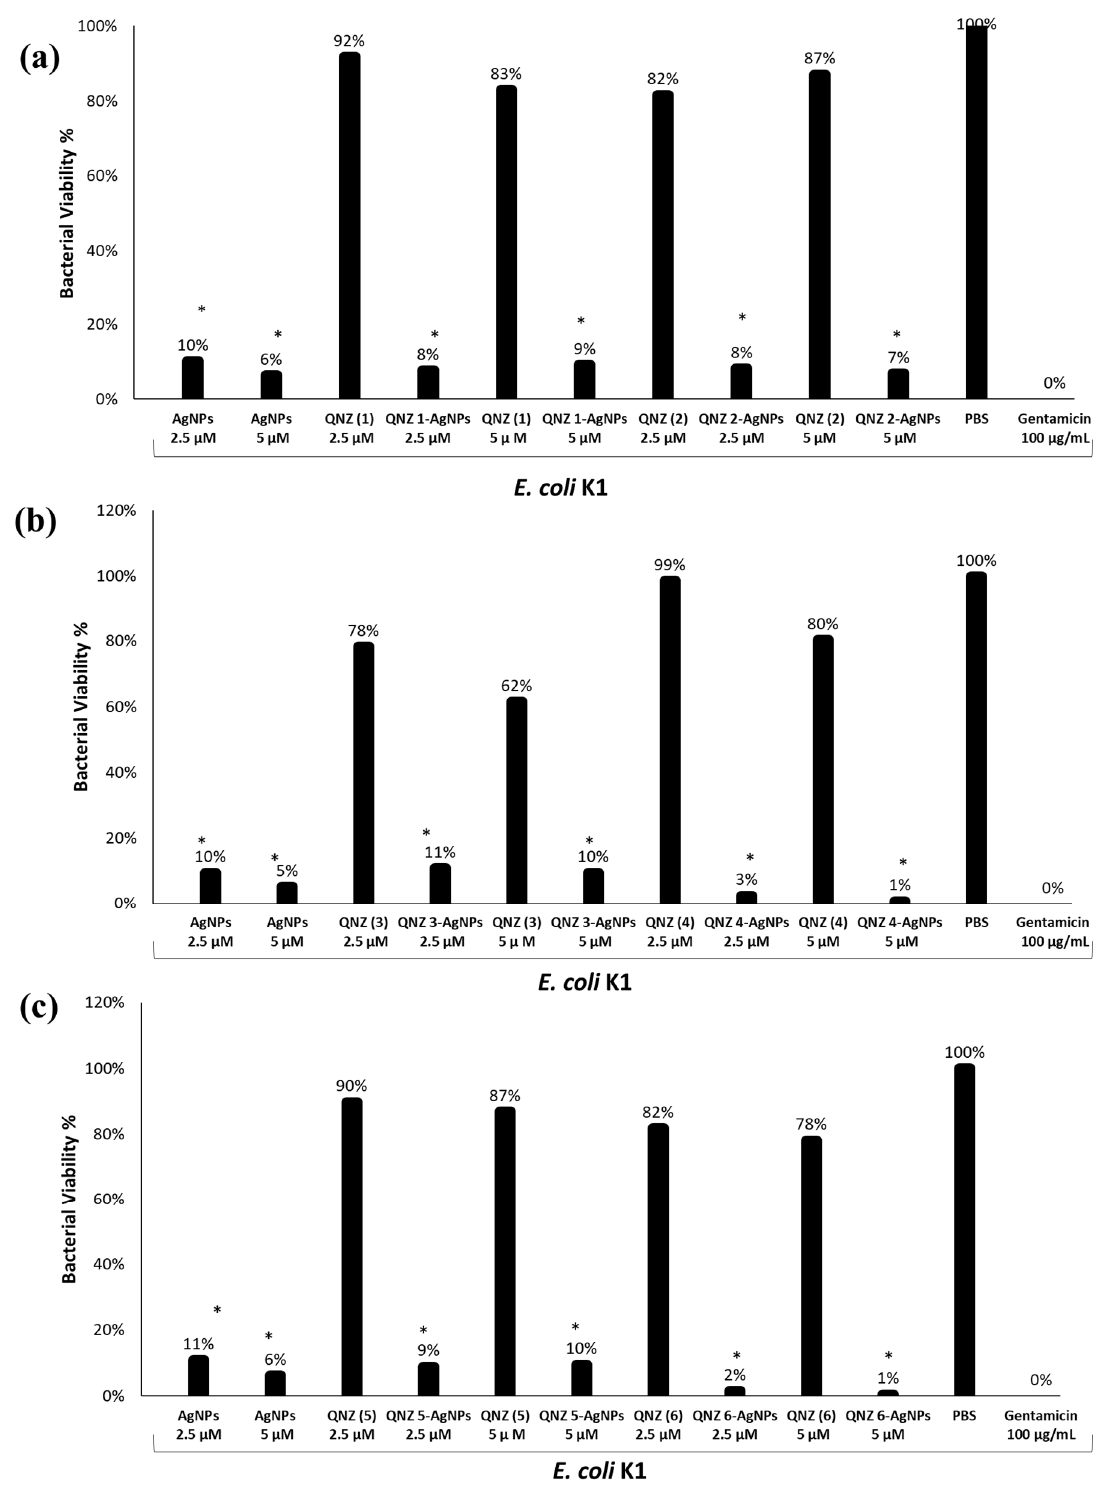
Figure 5. Bactericidal assay against E. coli K1( a – c ). The viability of bacteria was determined after assay as described in the materials and methods section. Briefly, 10 6 colony forming units (C.F.U.) were incubated with AgNPs alone, QNZ alone, and QNZ-AgNPs and negative and positive controls at 2.5 and 5 µM at 37 °C for 2 h. The next day, the cells were counted. Note all nanoconjugates showed bactericidal effects comparing with E. coli K1 alone but QNZ 4-AgNPs and QNZ 6-AgNPs had lower percentage of availability compared with AgNPs. The results are presented as the mean ± standard error of various experiments performed in duplicate. * indicates p < 0.05 using two-sample t test and two-tailed distribution.